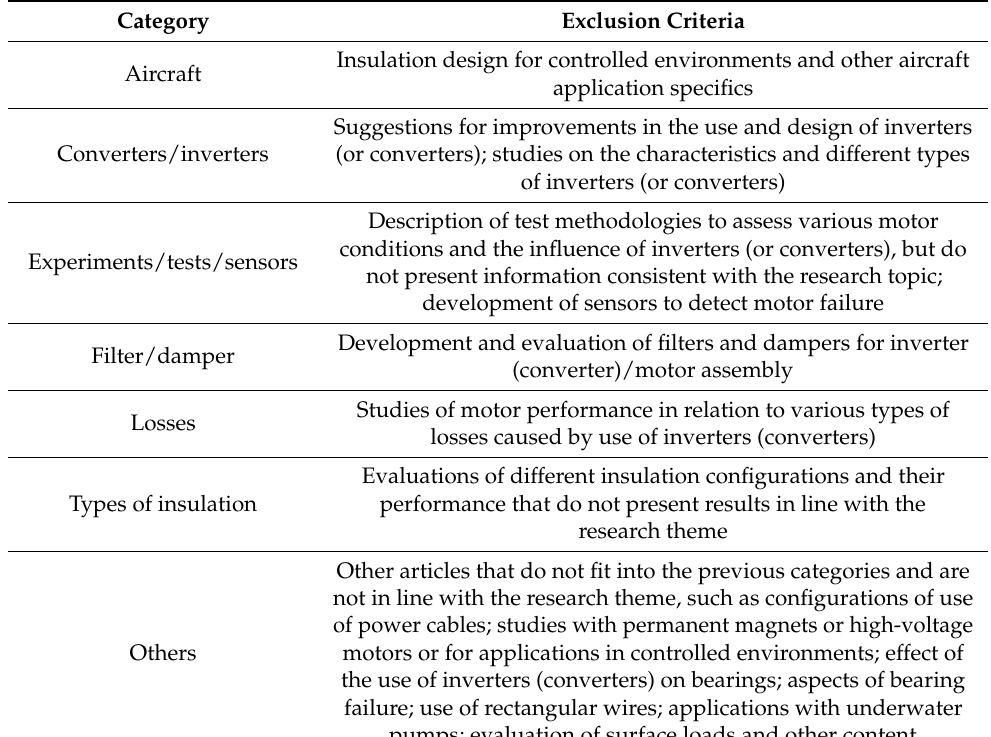
Table 1. Categories of articles excluded with respective criteria